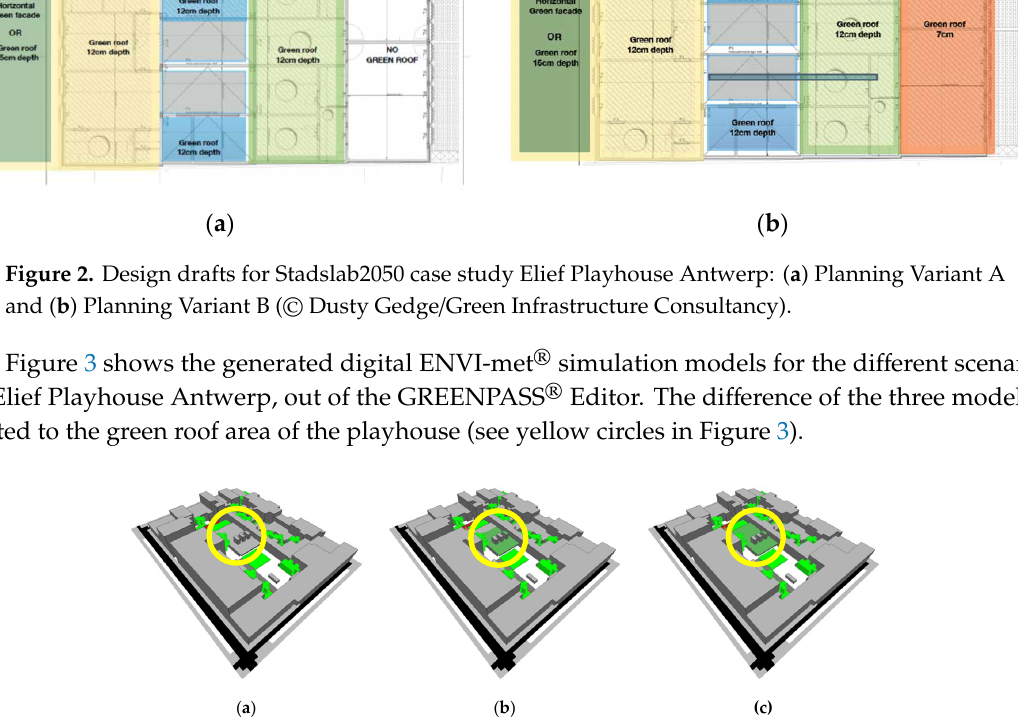
Figure 3. Digital ENVI-met ® simulation models out of GREENPASS ® Editor for Elief Playhouse Antwerp scenarios: ( a ) Status Quo (SQ), ( b ) Planning Variant A and ( c ) Planning Variant B.